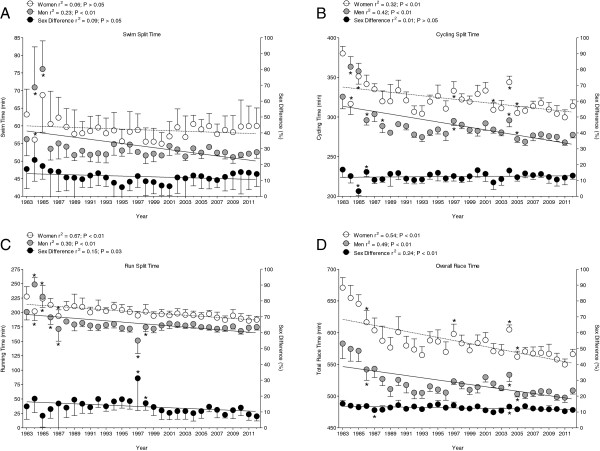
Change in swimming, cycling, and running split times and overall race times. (A) Swimming split times, (B) cycling split times, (C) running split times, and (D) overall race times of the overall top ten male and the overall top ten female finishers at the Ironman Hawaii. An asterisk indicates values which are significantly different from the previous one.